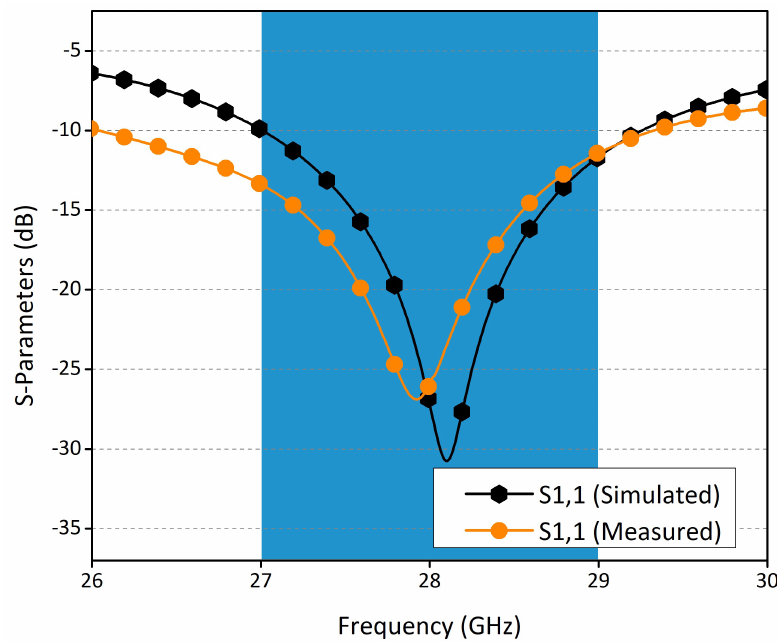
Figure 7. Reflection co-efficient of the proposed